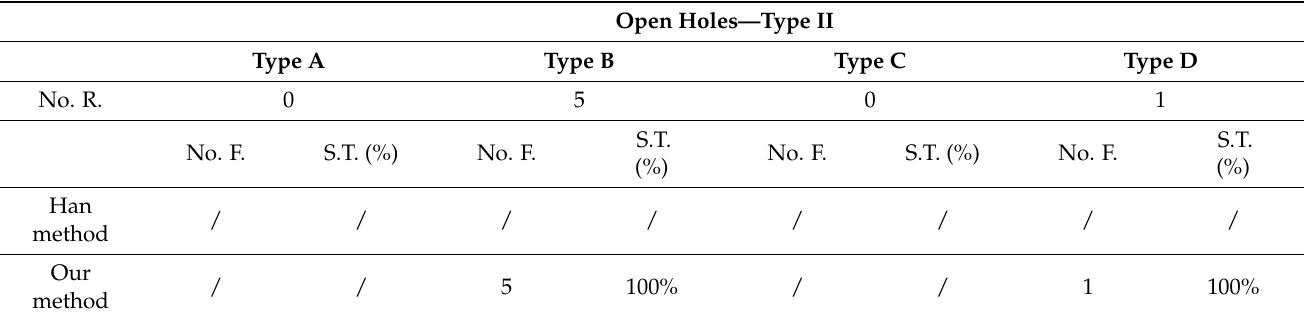
Table 5. Distribution and repair statistics of type II open holes.